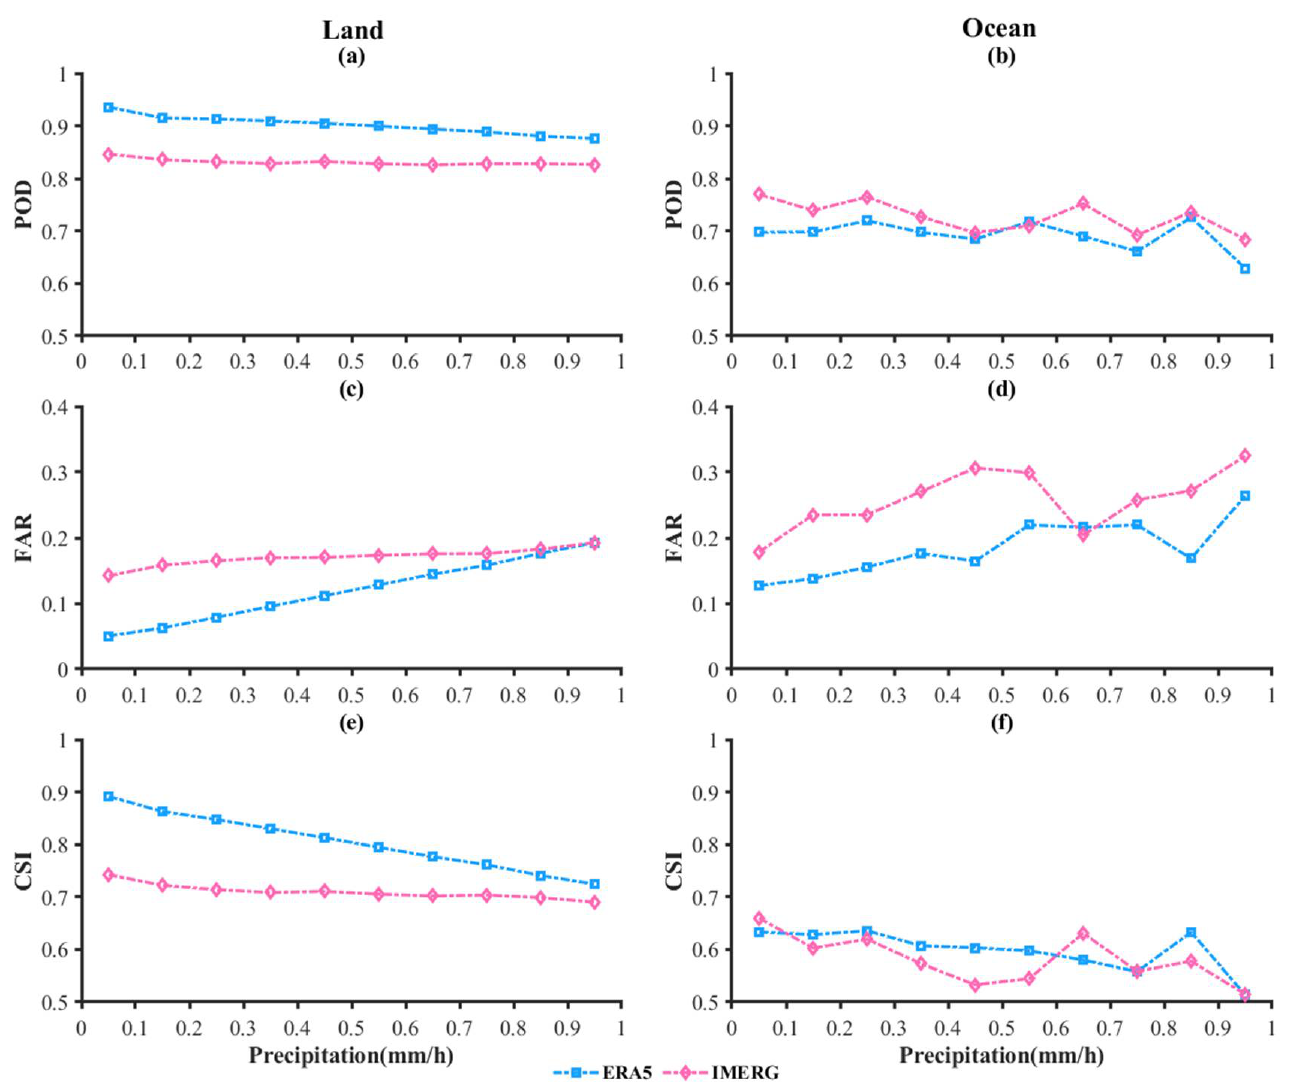
Figure 8. The POD, FAR, and CSI metrics for ERA5 and IMERG products for different precipitation intensities (mm/h) over global land and ocean. The subplots ( a , c , e ) refer to land, and the subplots ( b , d , f ) refer to ocean.